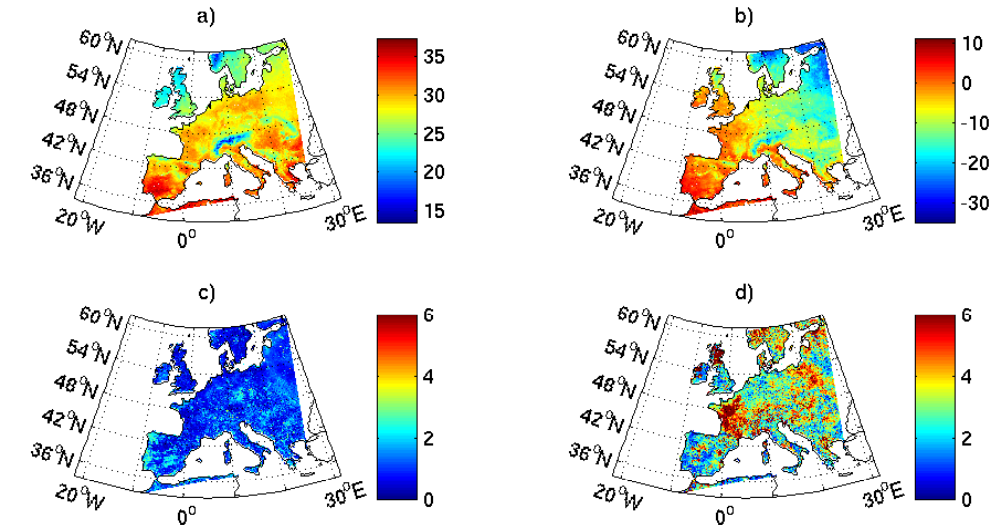
Figure 8. Recurrences analysis for eight EURO-CORDEX runs at m = 1 years. Average biases of models ( a ) for hot temperature extremes EMM for T max (as in Figure 6c for CMIP5) and ( b ) for cold temperature extremes EMM for T min (as in Figure 6a for CMIP5). Standard deviation of the biases of models ( c ) for hot temperature extremes SDM for T max (as in Figure 7c for CMIP5) and ( d ) for cold temperature extremes SDM for T min (as in Figure 7a for